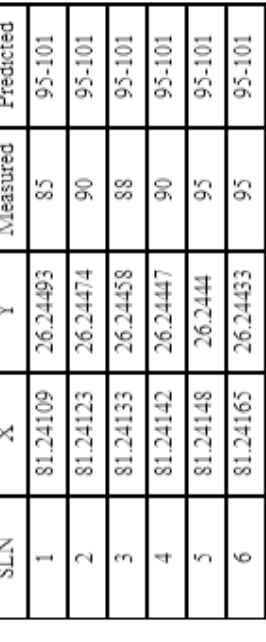
Table 1: Large Deviations between Measured and Predicted noise levels at Ratapur Crossing